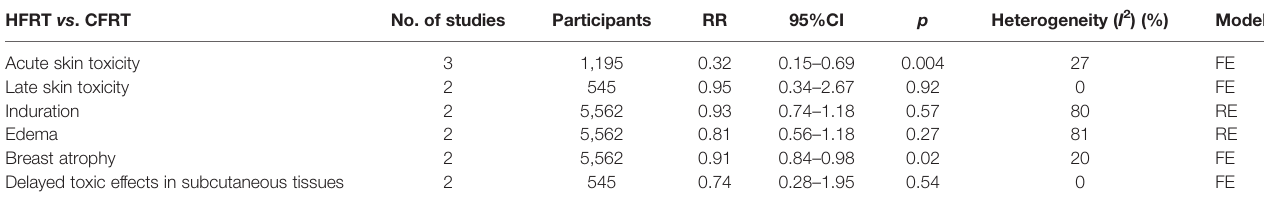
TABLE 3 | Moderate or marked adverse events for HFRT vs . CFRT. HFRT vs . CFRT